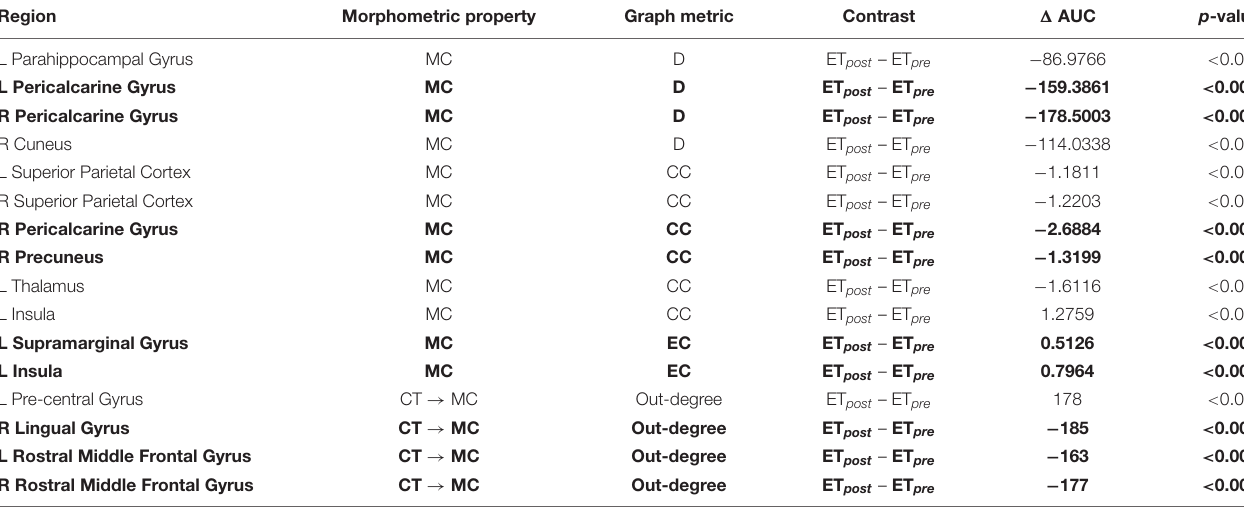
TABLE 2 | Summary of significant results.